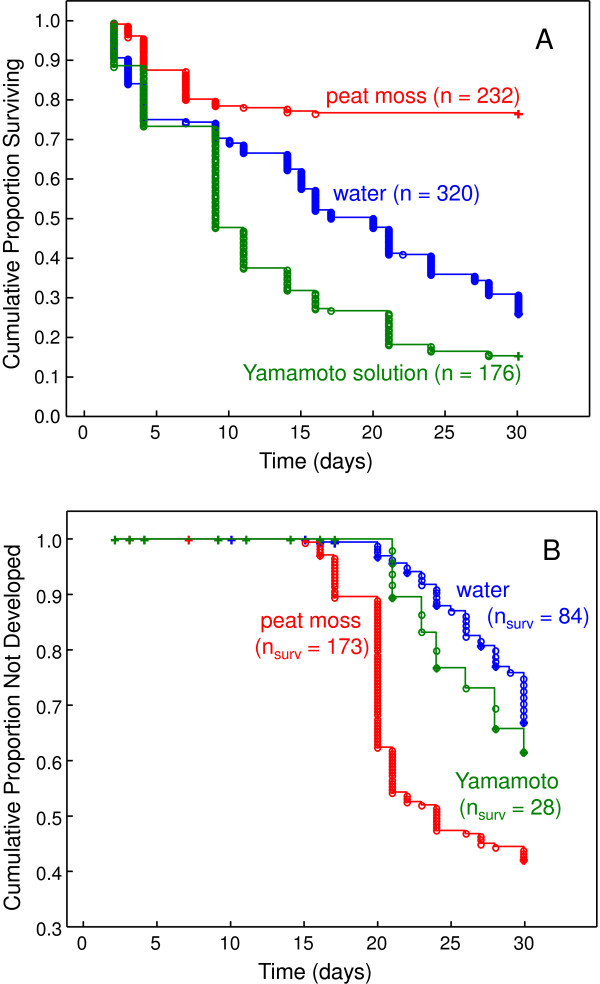
Embryo survival and development during the first 30 days. (A) Proportion of embryos surviving on different developmental substrates visualized by Kaplan-Meier estimate. Sample size for each category is given in parentheses. (B) Proportion of embryos hatched at a given time when incubated on different substrates visualized by Kaplan-Meier estimate. The number of embryos surviving the experimental period for each category is given in parentheses.